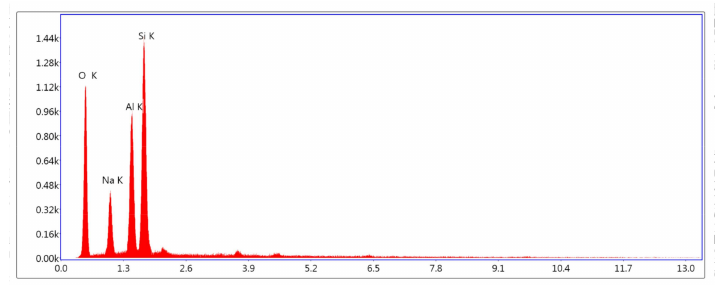
Figure 19. Element analysis of needle product from